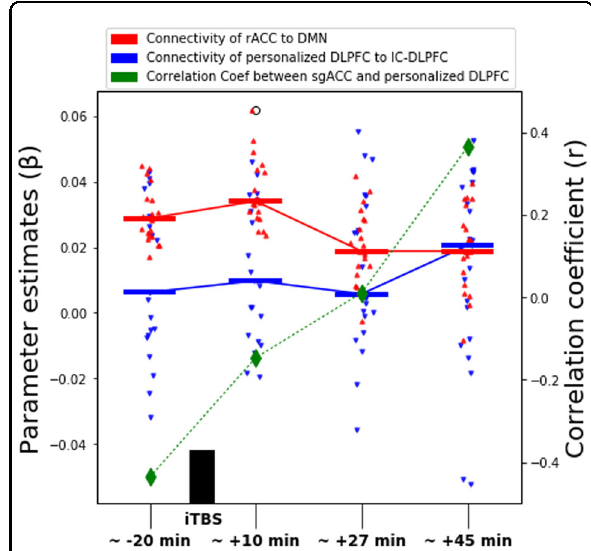
Fig. 4 Parameter estimates of left DLPFC and rACC. Left axis shows the parameter estimates of left DLPFC (blue) and rACC (red) of IC- DLPFC and DMN, respectively. Dots represent the individual values and horizontal lines depict the median of the parameter estimates for the respective rsfMRI window. The right axis plots the correlation coef fi cients between the DLPFC and the rACC, showing that the effect of a single session of iTBS progressively changes the correlation between these ROIs from negative to positive.